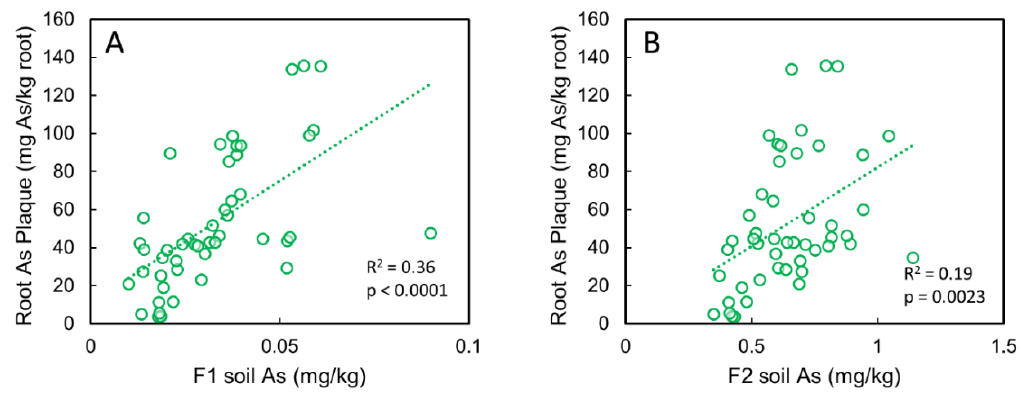
Figure 7. Positive relationships between plaque As and soil-extractable As in the ( A ) F1 fraction and ( B ) F2 fraction from the field study.